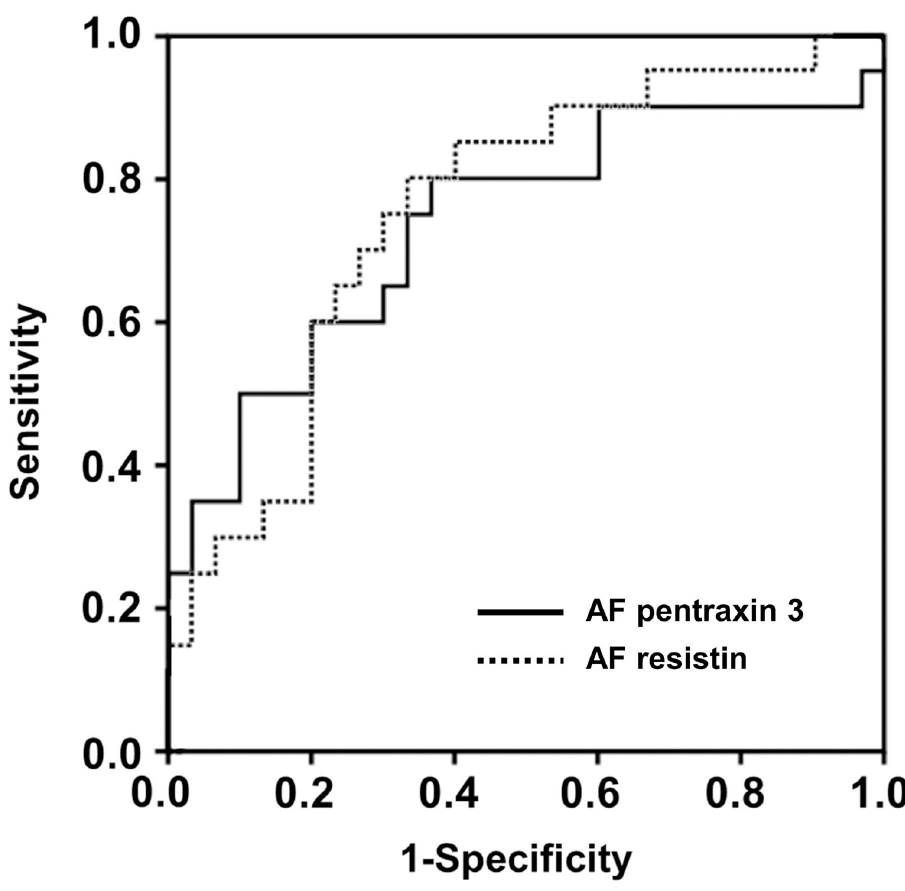
Fig 2. Receiver-operating characteristic curves for prediction of spontaneous preterm delivery at < 28 weeks of gestations by the AF levels of the pentraxin 3 and resistin. PTX3: AUC, 0.737 ± 0.077; P = 0.005. resistin: AUC, 0.755 ± 0.070; P = 0.001. AF, amniotic fluid; AUC, area under the curve ± standard error.